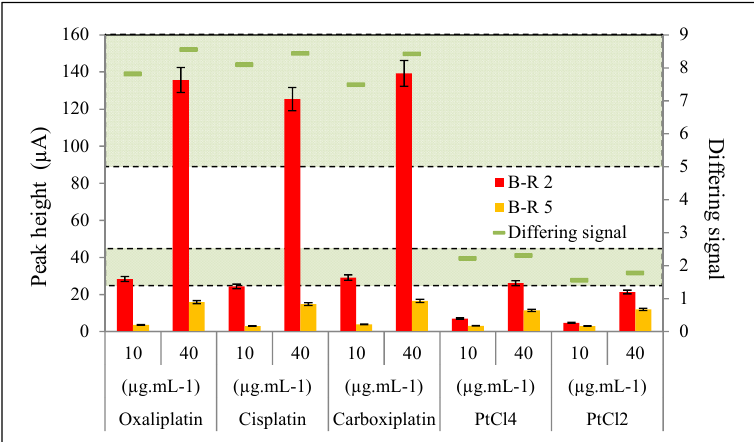
Figure 5. Results of analyzes of water from the stream after the addition of each variant of platinum. Samples in the B-R buffer, pH 2 are shown in a red column, and pH 5 as an orange column. Green marks show the ratio of buffers used, and concurrently also determine the variations of